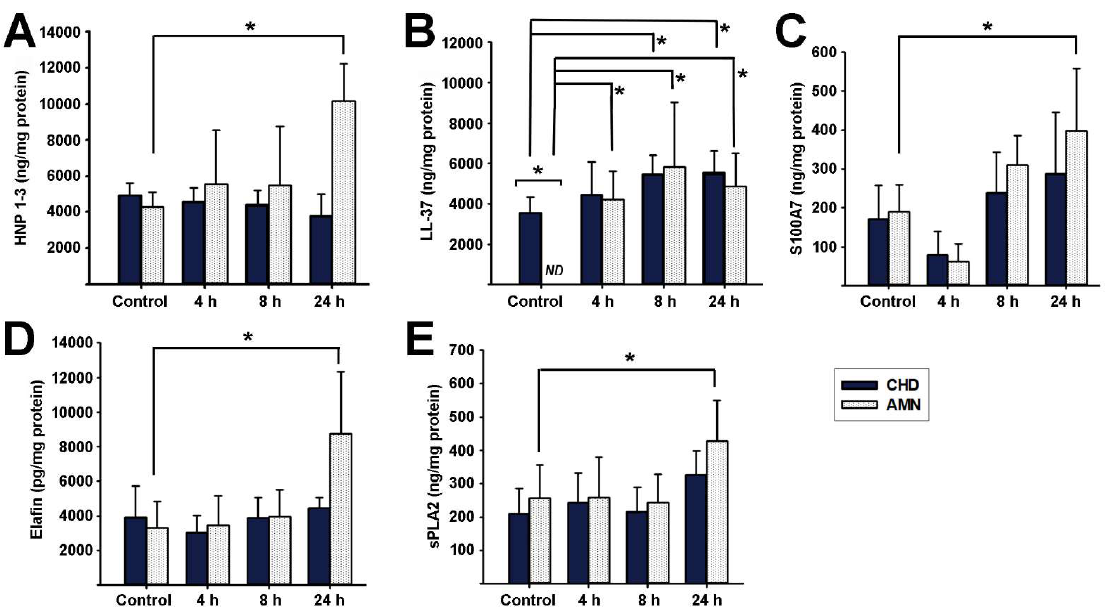
Figure 5. Effect of choriodecidual infection with Escherichia coli upon antimicrobial peptide synthesis. An inoculum of 1 × 10 5 CFU/mL E. coli was used to infect the CHD compartment. The tissue layers were lysed to evaluate the specified AMP content at each follow-up time point (control, 4, 8, and 24 h). ( A ) HNP-1-3, ( B ) LL-37, ( C ) S100A7, ( D ) Elafin, and ( E ) sPLA2. AMP synthesis by the amnion (AMN) is shown in white bars, whereas synthesis by the choriodecidua (CHD) is shown in blue bars. The data are presented as means ± SD. n = 4–5 independent experiments in duplicate. * p < 0.05. ND = non-detectable.